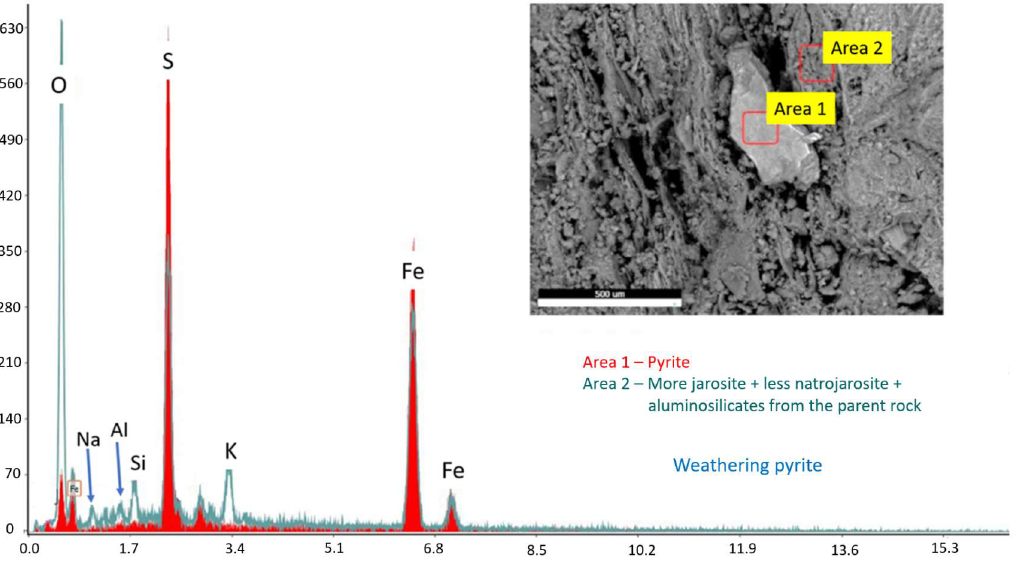
Figure 23. BSE image with areas selected for EDS analyses (inset) and the corresponding overlayered EDS spectra. The pyrite-containing particle under weathering condition is surrounded by jarosite and natrojarosite formations and aluminosilicates of the surrounding rock material.